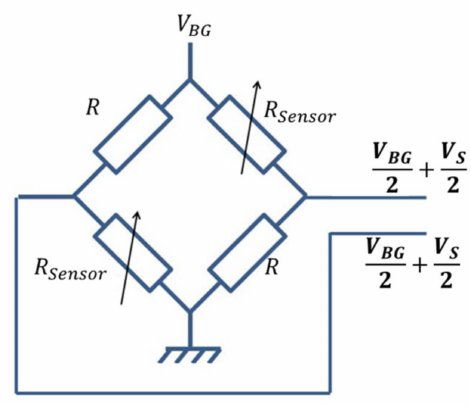
Figure 11. Wheatstone bridge